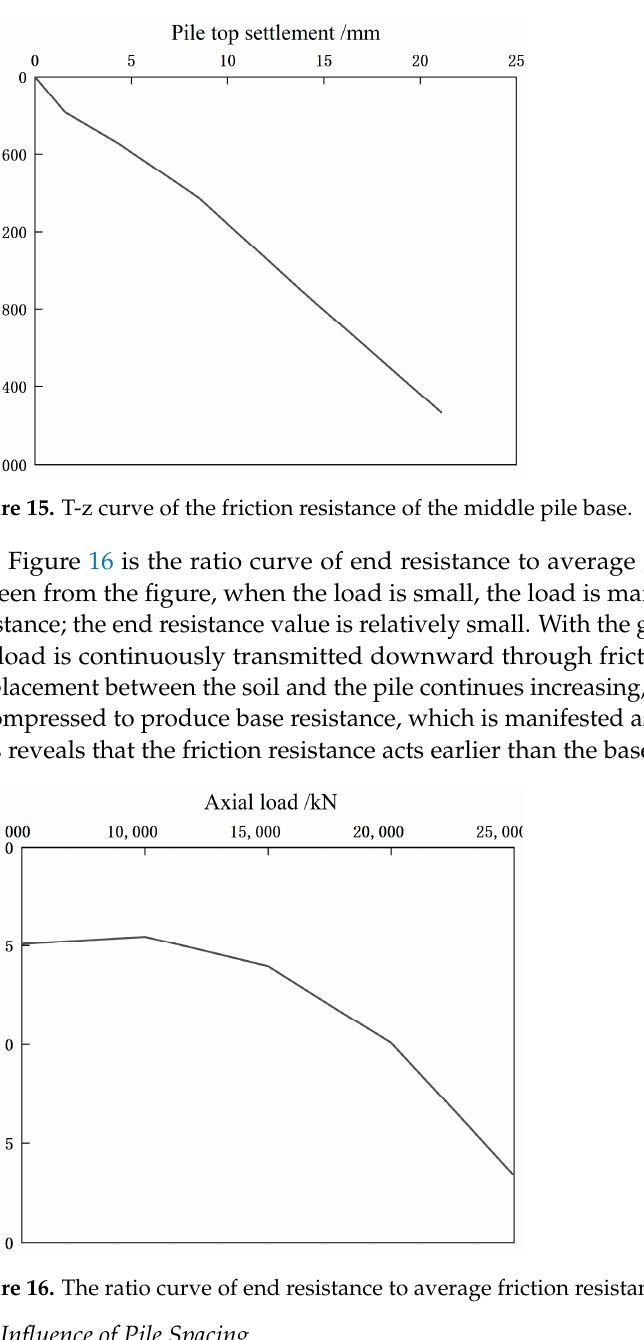
( c ) Figure 17. Axial stress of each pile in a pile group with different pile spacing. ( a ) Axial stress distri- bution of the central pile; ( b ) axial stress of the side pile; ( c ) axial stress distribution of the corner pile.